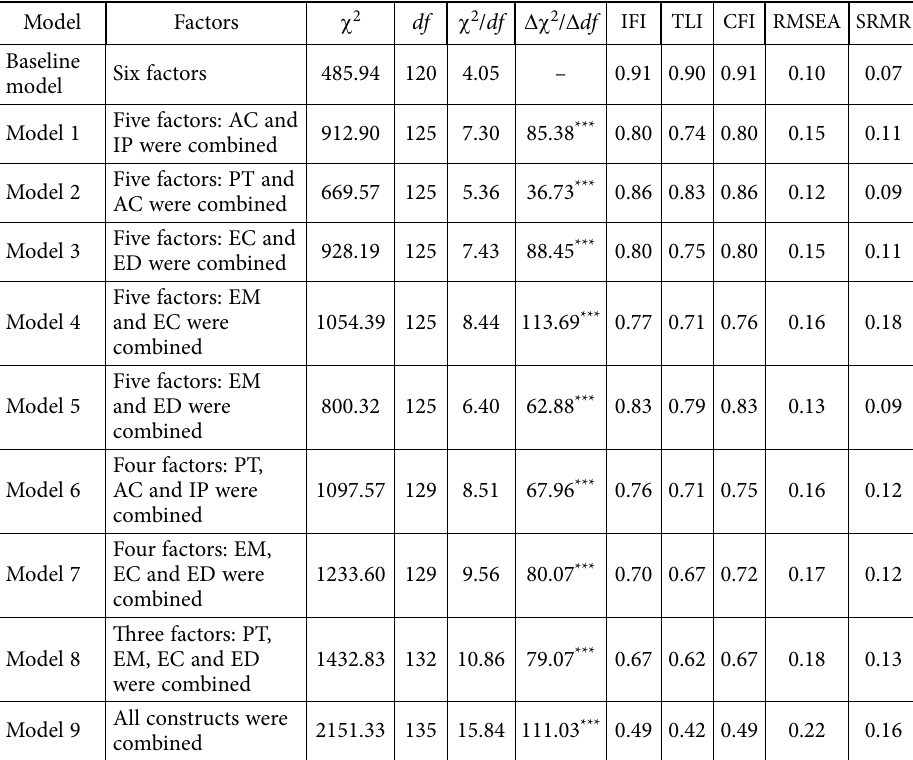
Table 3. Comparison of the measurement